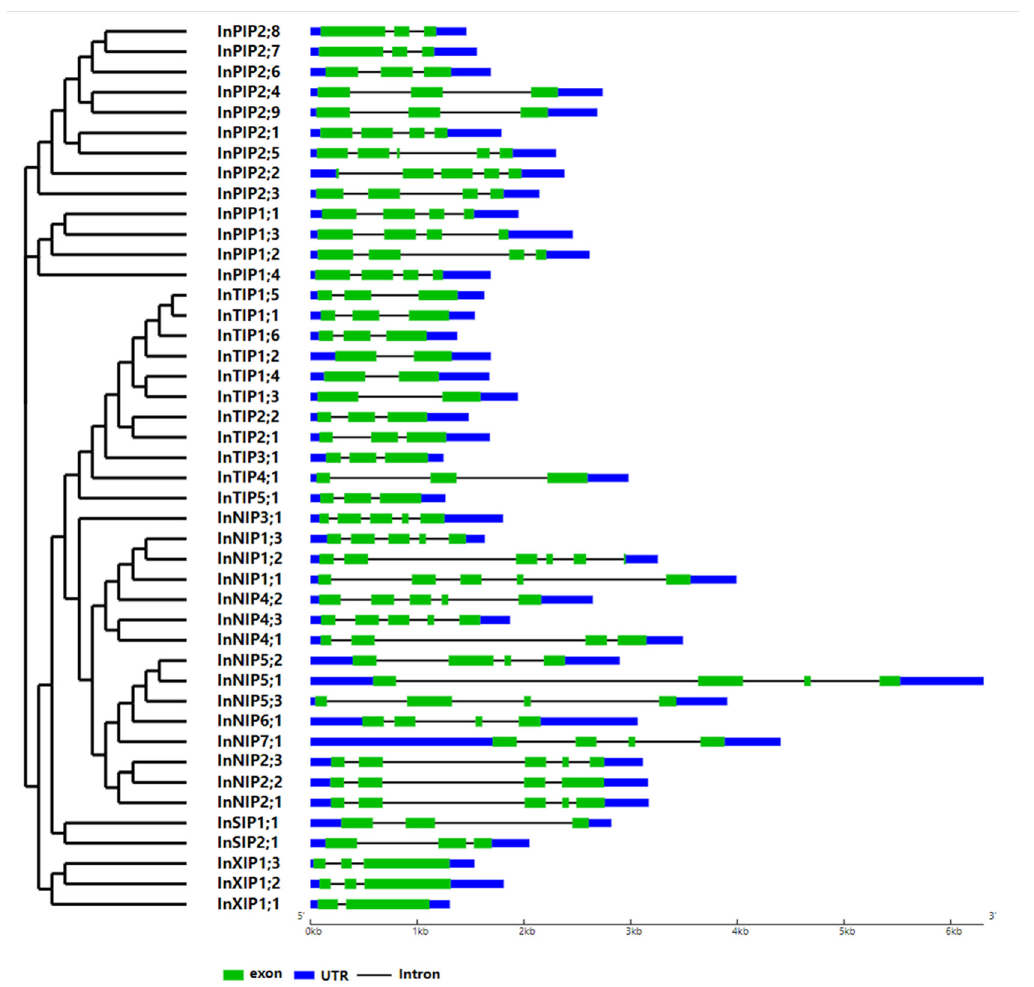
Figure 3. Exon–intron structure of the AQP genes of Japanese morning glory. A graphic represen- tation of the gene models of all 44 AQPs identified in this study. Gene models are based on genome and CDS sequences. Table 1. AQP genes identified in the Japanese morning glory genome.